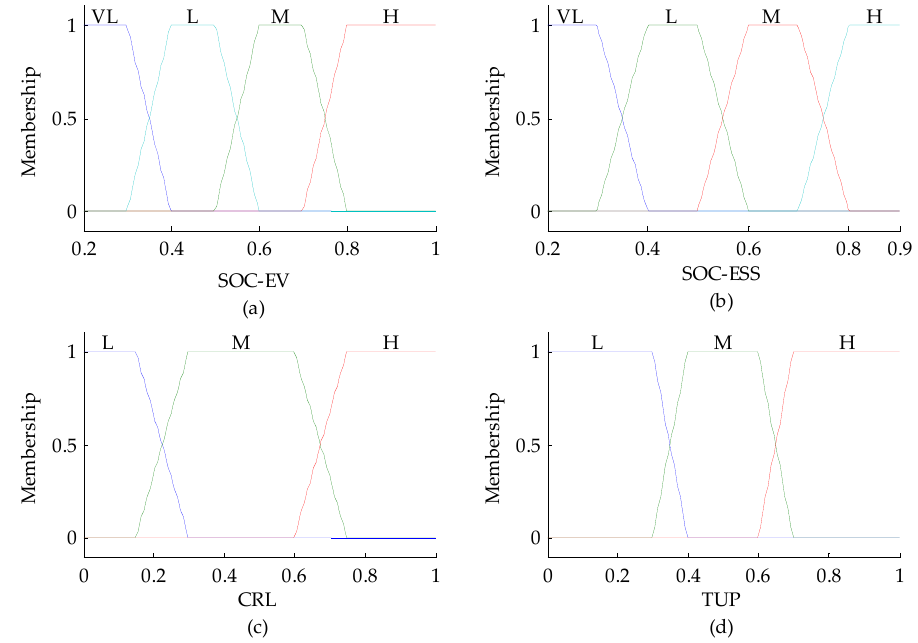
Figure 3. Membership function of input variables on the weight of ( a ) EV state of charge, ( b ) ESS state of charge, ( c ) calculated remaining load and ( d ) time-of-use price.